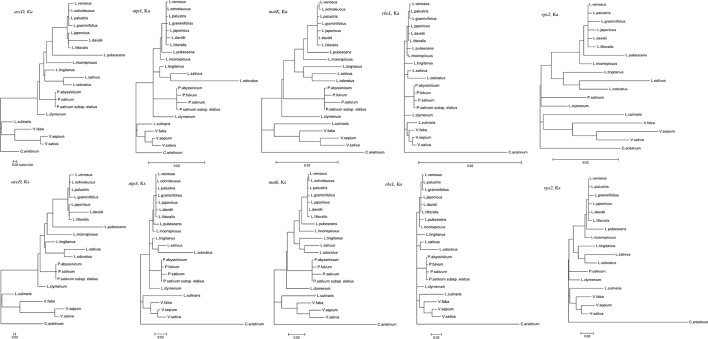
Synonymous and nonsynonymous divergence in the Fabeae chloroplast genes. All tree topologies were completely constrained as described in the Methods section. All trees were drawn to the same scale representing the number of substitutions per synonymous or nonsynonymous site.